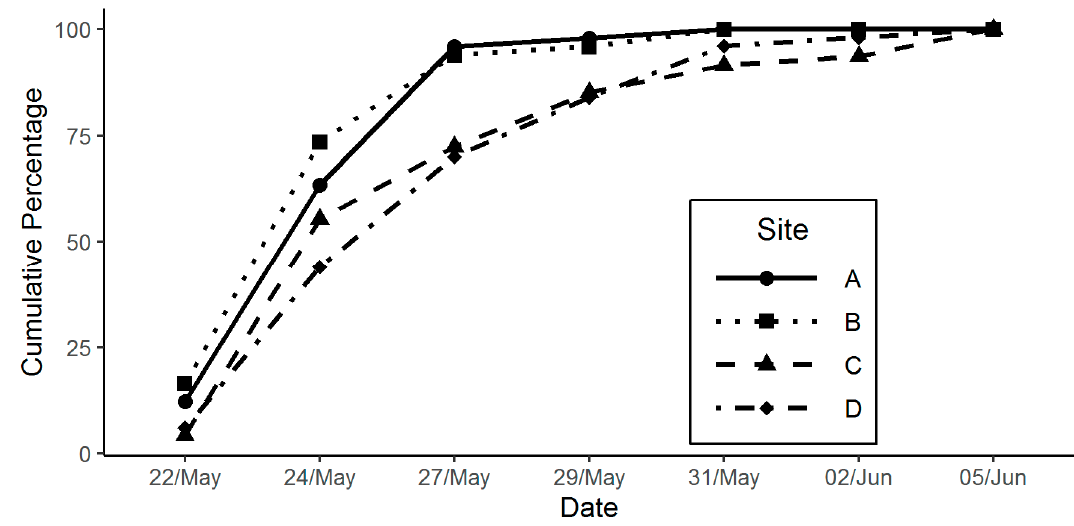
Figure 2. Cumulative percentage of trees reaching the final stage of bud break by site.